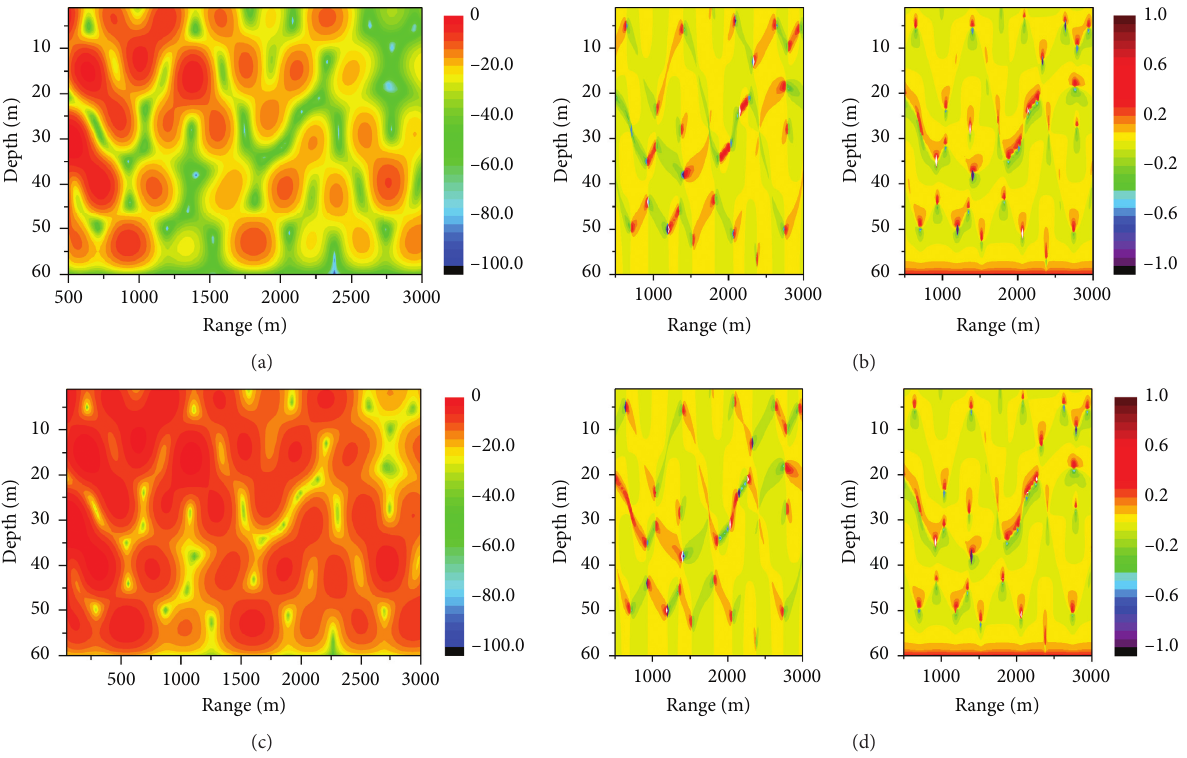
Figure 12: (a) Normalized | p 2 | field of a unit point source. (b) Normalized acoustic intensity field of the point source (left: I ∗ Normalized | p 2 | field of the cylindrical shell. (d) Normalized acoustic intensity field of the cylindrical shell (left: I ∗ z ; right: Q ∗ z ) � 360Hz). ( h U � 20m and f 0